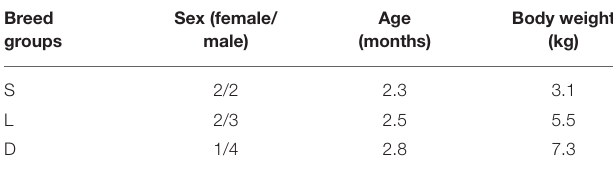
TABLE 2 | Primary ingredients and nutritional composition of the utilized diets.